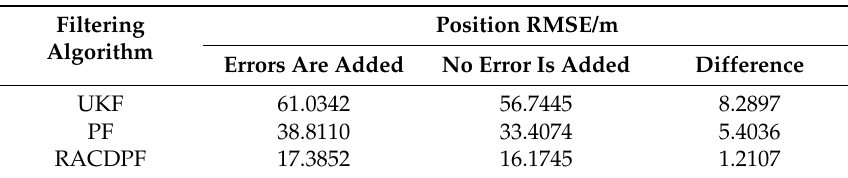
Table 8. Robustness performance of the nonlinear filtering